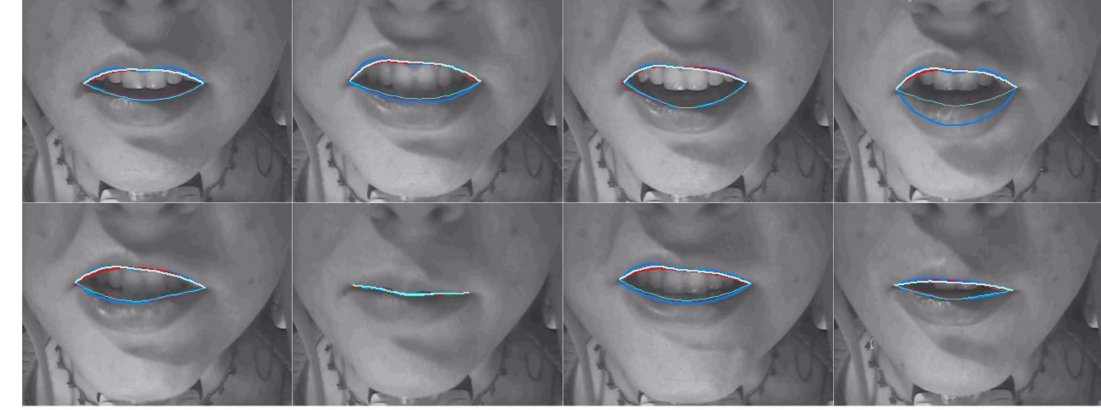
Figure 16. Speaker 25fs; blue—hand-label; red—MobileNetV2; cyan—ResNet50.